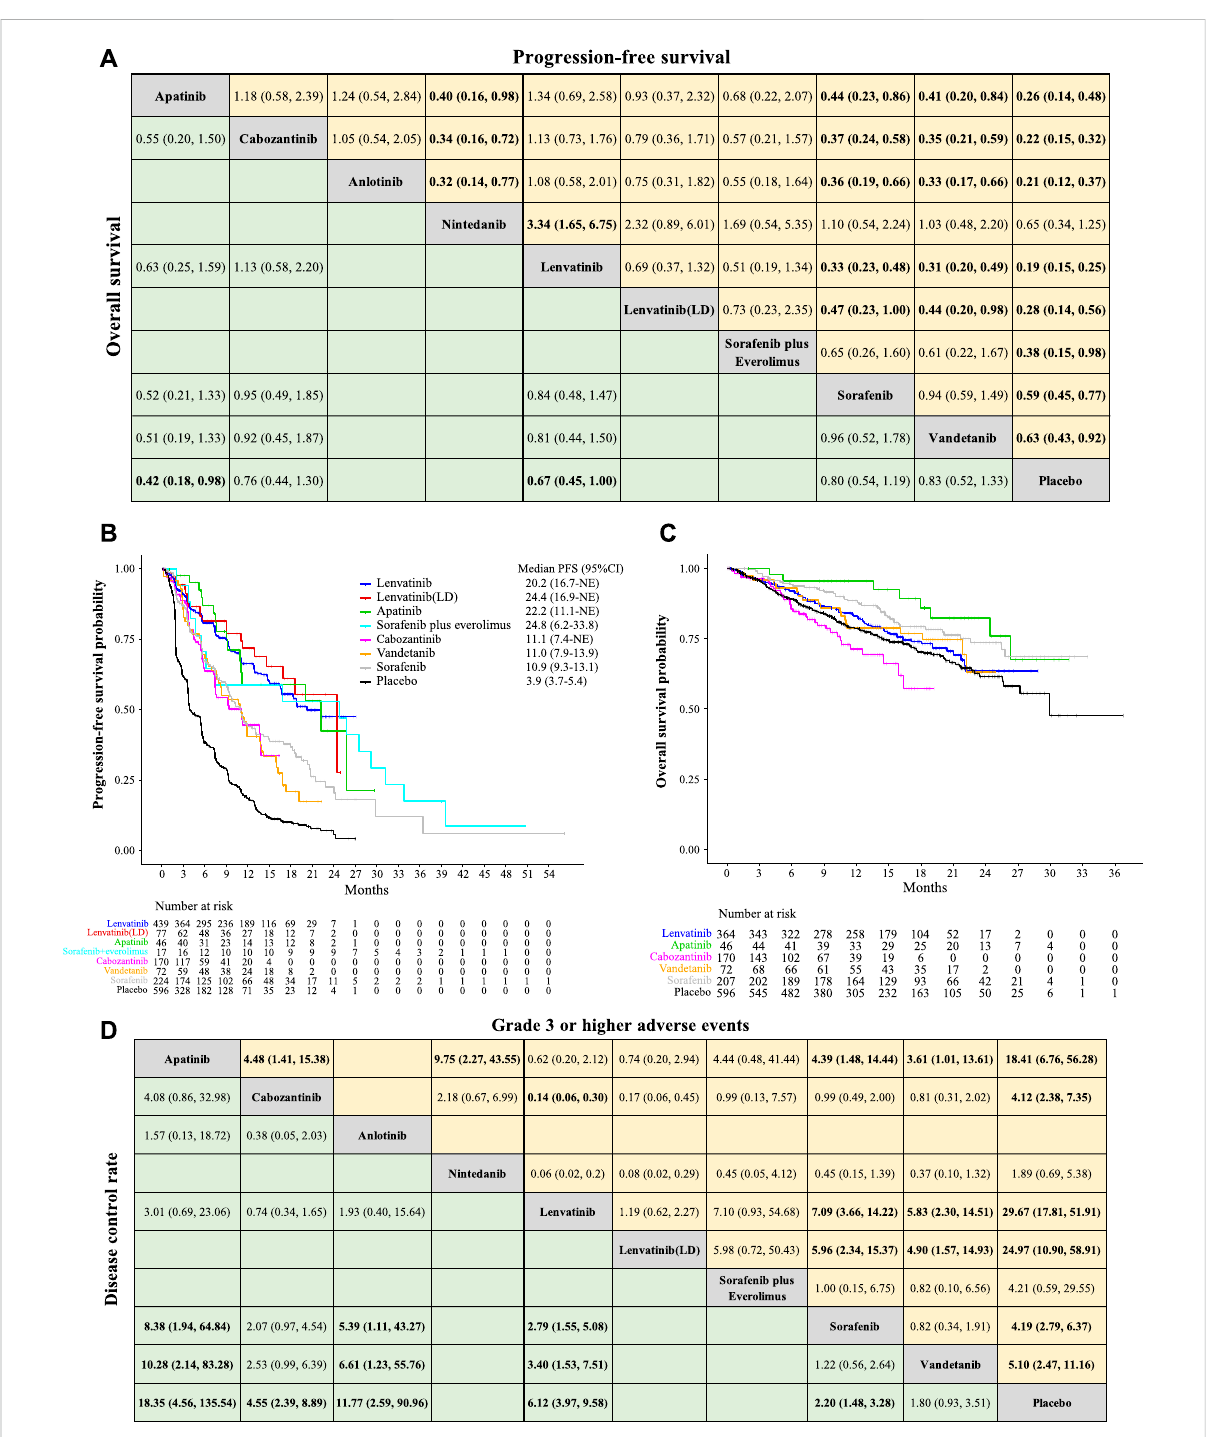
FIGURE 3 Network meta-analysis of a comparison of different treatments on PFS, OS, DCR, and P 3 AEs in patients with radioiodine-refractory differentiated thyroid cancer. (A) Pooled estimates of the network meta-analysis of progression-free survival (PFS) and overall survival (OS). Data on each cell isahazard ratio (HR) (95% CrIs) for the comparison of row-de fi ningtreatmentversuscolumn-de fi ningtreatment. The HRless than 1 favors upper-row treatment. Signi fi cant results are highlighted in bold. (B) Reconstruction of the Kaplan – Meier curve of PFS for each treatment with median PFS. (C) Reconstruction of the Kaplan – Meier curve of OS for each treatment. (D) Pooled estimates of the network meta-analysis of the disease control rate (DCR) and grade 3 or higher adverse events ( P 3 AEs). Data on each cell is an odds ratio (OR) (95% CrIs) for the comparison of row-de fi ning treatment versus column-de fi ning treatment. The OR greater than 1 favors upper-row treatment. Signi fi cant results are highlighted in